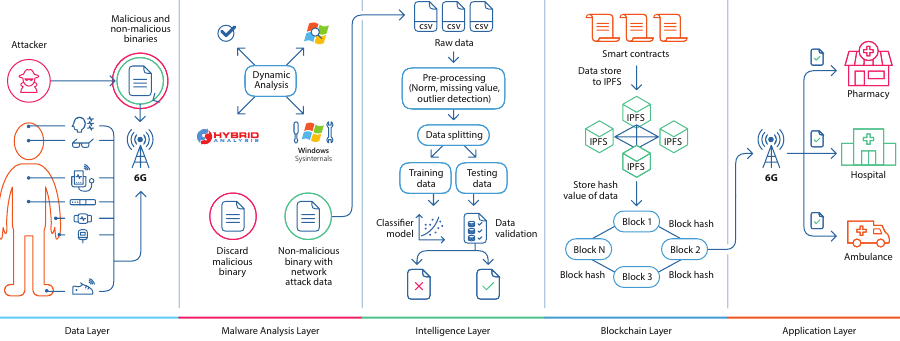
Figure 4. Smart healthcare architecture for mitigating security